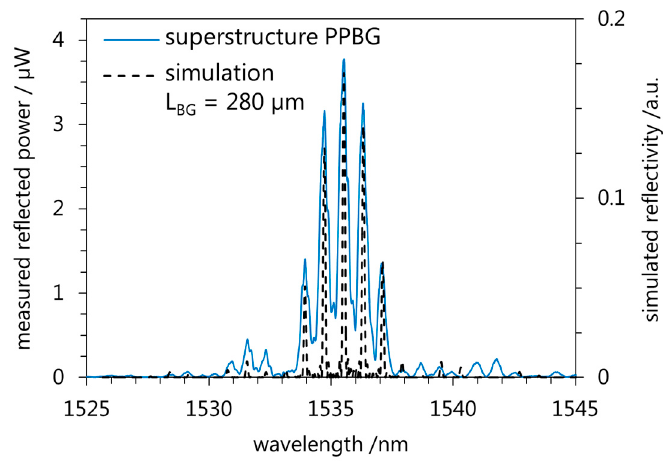
Figure 5. Measured reflected spectrum of the fabricated superstructure PPBG in comparison with a simulation based on L BG being 280 µm.